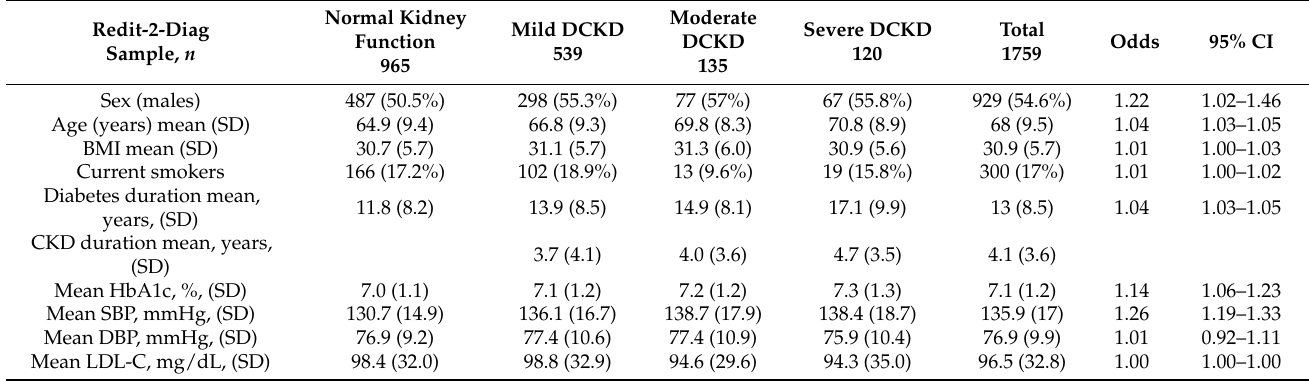
Table 1. Patient demographics and disease characteristics. Two-group analysis (normal kidney function vs. DCKD). Values are presented as a percentage (%) of the total number or as a mean ± standard deviation (SD). DCKD: Diabetic Chronic Kidney Disease, BMI: Body Mass Index, CKD: Chronic Kidney Disease, SBP: Systolic Blood Pressure. DBP: Diastolic Blood Pressure, LDL-C: Low Density Lipoprotein-Cholesterol. Redit-2-Diag Sample,